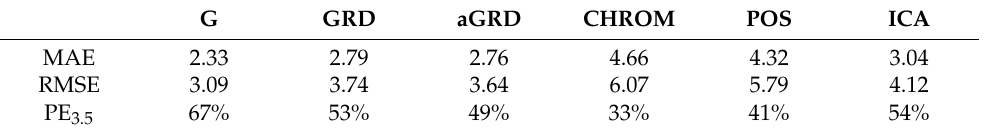
Table 2. Accuracy and computing complexity comparison of different methods performed on the anaesthetized pig and presented as mean absolute error (MAE), root mean square error (RMSE) and percentage of HR error below 3.5 beats per minute when compared to the gold standard.